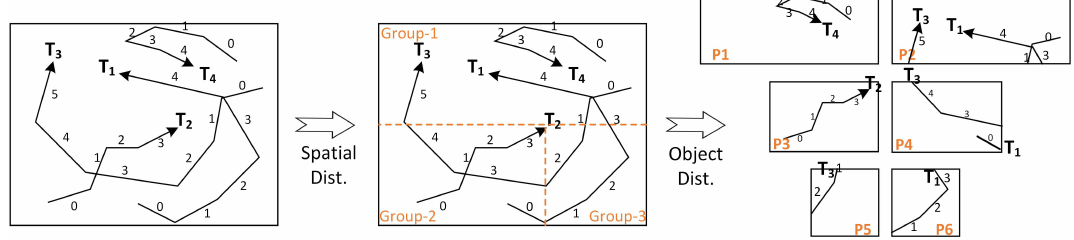
Figure 1. Partitioning phase in Resilient Moving Object Index (RMOI) with α = 3 and β = 2.